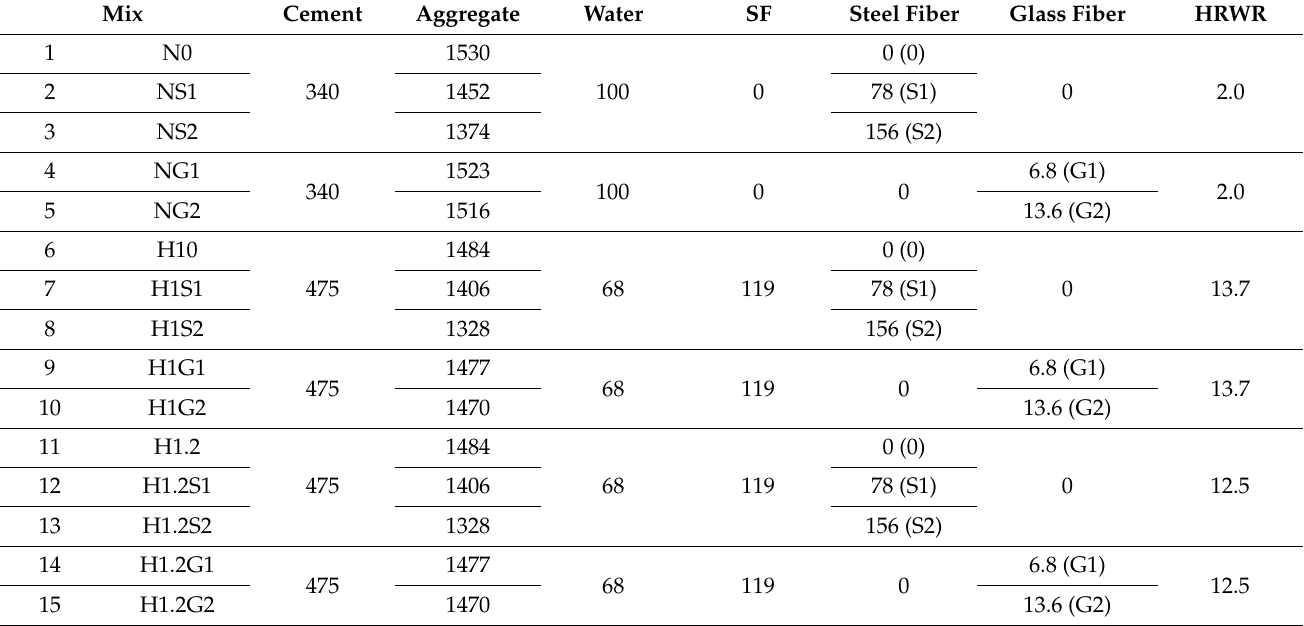
Table 4. Mix design for normal and high-strength pervious fiber concretes (kg/m 3